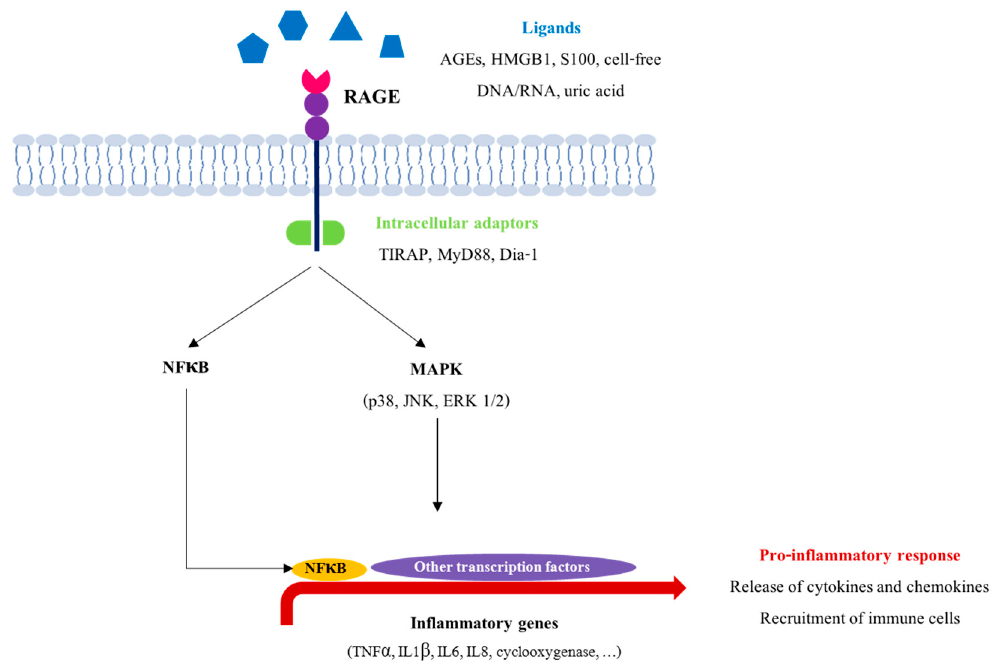
Figure 4. RAGE signaling pathway. Following the binding of its ligands, RAGE can induce different proinflammatory pathways, implicating some adaptor intracellular proteins (TIRAP, MyD88, Dia-1). This activation results in the induction of proinflammatory gene transcription (TNF α , cyclooxygenase 2, IL1 β , IL6, IL8), thus maintaining the inflammation phenomenon.